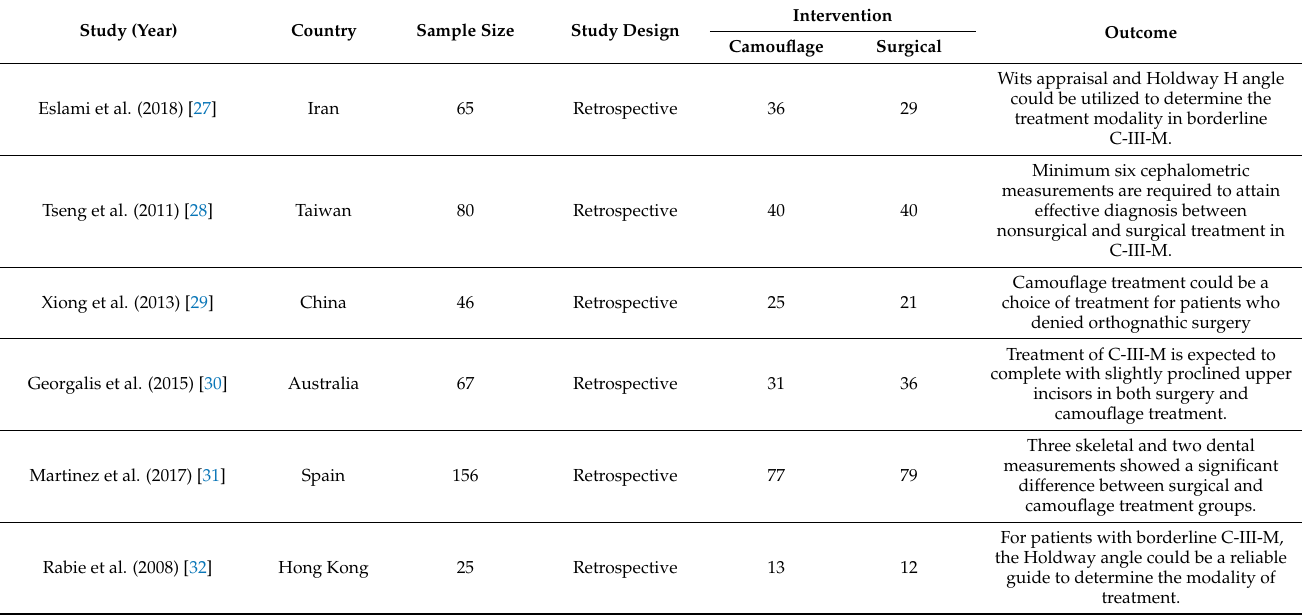
Table 2. List of included studies.